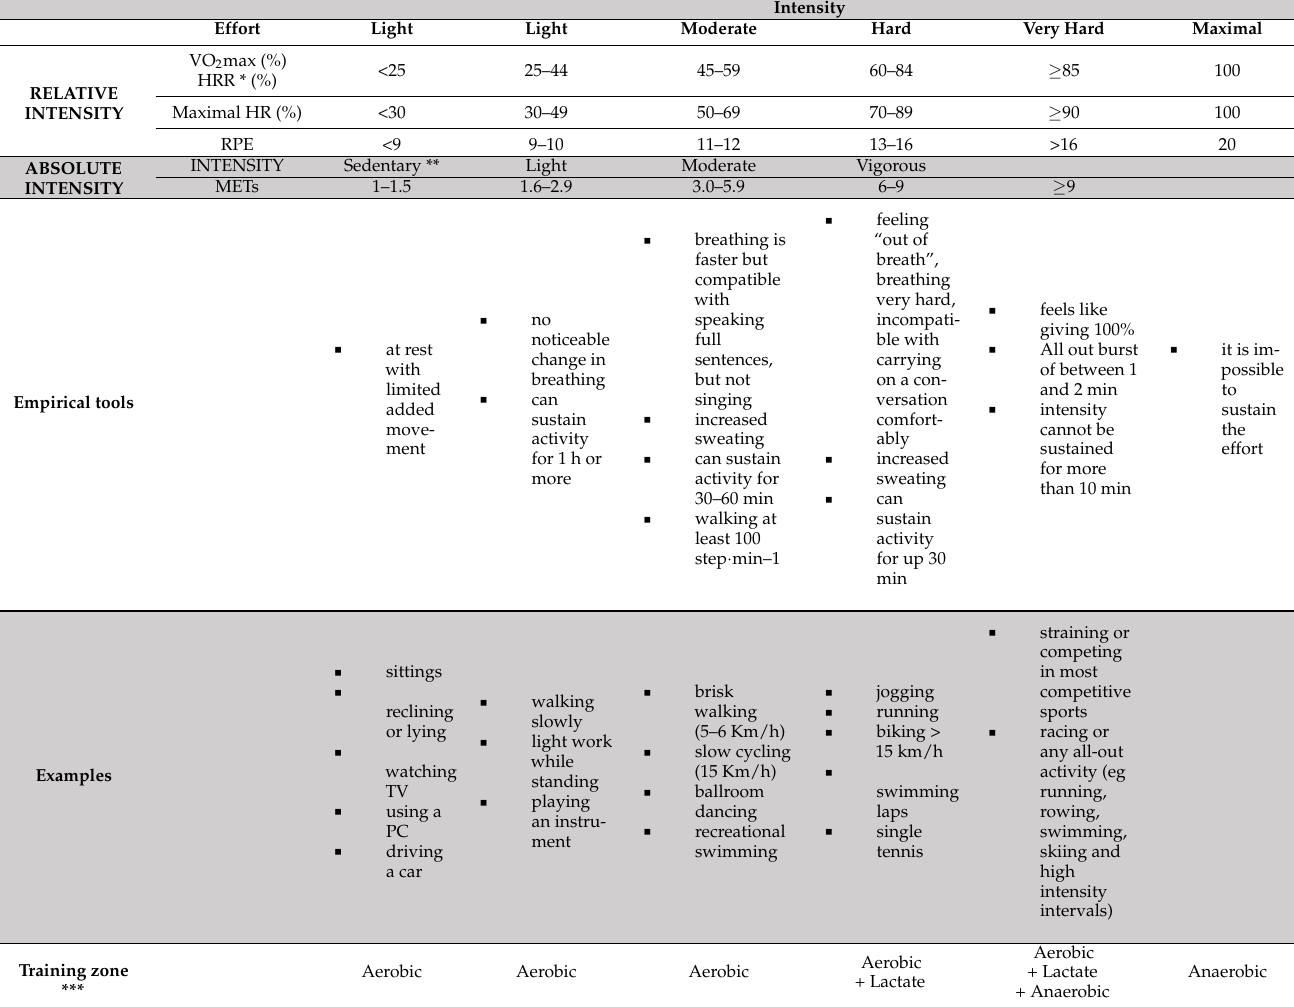
Table 4. Classification of physical activity intensity.